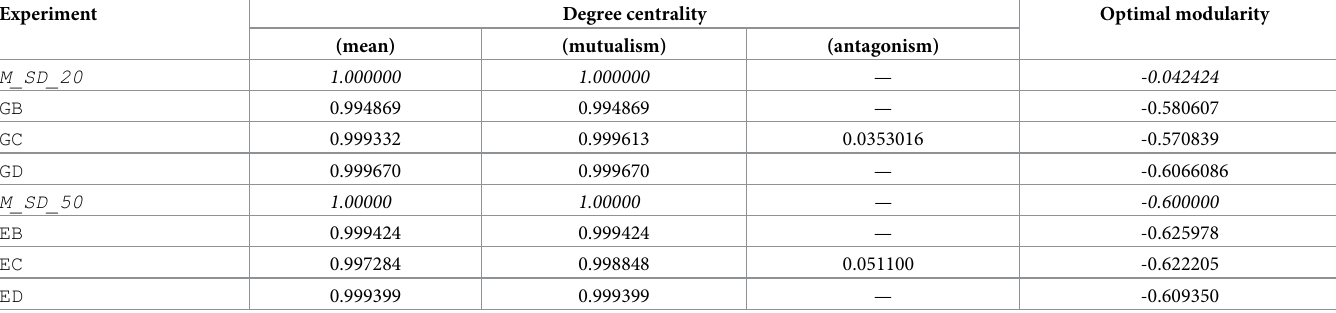
Table 2. Spearman correlation coefficients between structural stability and several graph measures for the experiments with biological networks, considering 10 γ - bipartite graphs of 10 + 10 nodes given from selected subnetworks of seed-dispersal networks (first row) and 4 γ -bipartite graphs of 20 + 30 or 30 + 20 nodes given from selected subnetworks of seed-dispersal networks (fifth row). The rest of rows correspond to the several sets of synthetic random graphs: 500 γ -bipartite graphs of 10 + 10 nodes (rows 2-4) and 500 γ -bipartite graphs of 20 + 30 nodes (rows 6-8). See Table 1 for details on how γ ij and β ij are